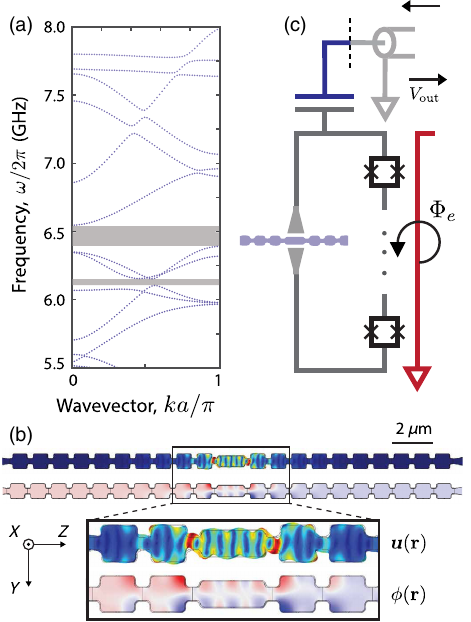
FIG. 1. Concept and design. (a) Phononic bands of a LiNbO 3 quasi-one-dimensional phononic crystal with lattice constant a ¼ 1 μ m, showing the bands of all possible mode polarizations in the range of frequencies relevant to this work. A complete band gap near ν ¼ 6 . 5 GHz is clearly visible, with a narrower gap also visible below. Other relevant simulation parameters (matching those of the fabricated structures) are the length and width of the connecting struts (320 nm and 240 nm, respectively), the film thickness (224 nm), and the sidewall angle (5°). (b) Deformation u ð r Þ and electrostatic potential ϕ ð r Þ of a mode localized at the defect site, at frequency ν ¼ 6 . 48 GHz near the center of the band gap. Modes of this polarization can be coupled to electric fields pointing in the direction perpendicular to the crystal lattice. Here, 1 . 6 μ m and the length and width of the defect are a def ¼ 500 nm, respectively. (c) Schematic of the device, includ- w def ¼ ing the drive (or read-out) line (blue) capacitively coupled to the resonator, the flux line (red) used to flux bias the SQUID array, and the electrodes (gray) that couple the circuit to the phononic cavity (light blue). The LiNbO 3 crystal axes are